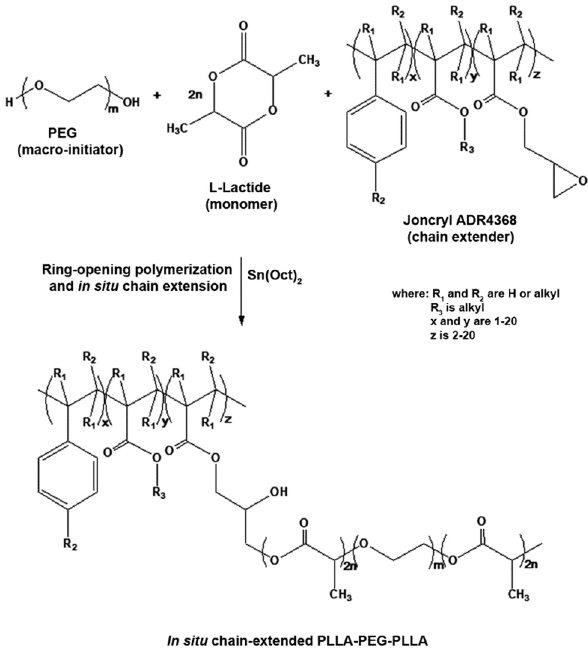
Figure 1: Synthesis reaction of in situ chain - extended PLLA - PEG - PLLA by ring - opening polymerization and in situ chain